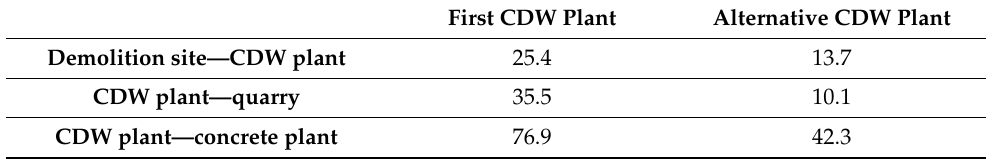
Figure 8. Original CDW plant (CDWp), darker color and alternative CDW plant (aCDWp), lighter color. Table 7. Comparison of the distance (in km) between the first CDW plant and the alternative